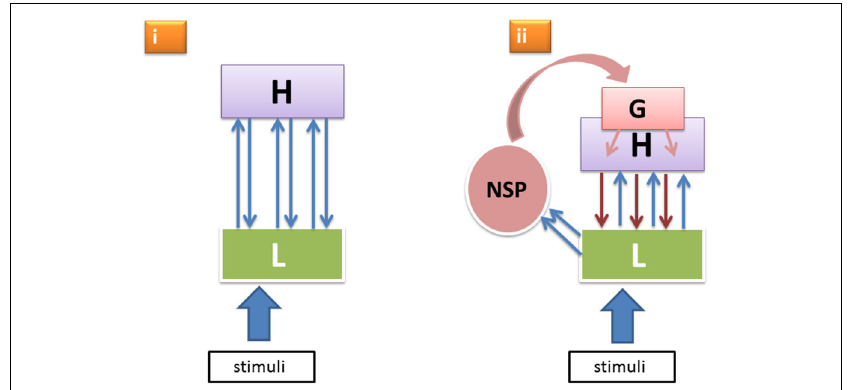
FIGURE 1 | Two alternative modes (i, ii) of top–down effects within the hierarchical perceptual processing system featuring specific low level neural units L, higher level specific nodes H, and a generic non-specific activation G boosted by the non-specific thalamocortical afference from